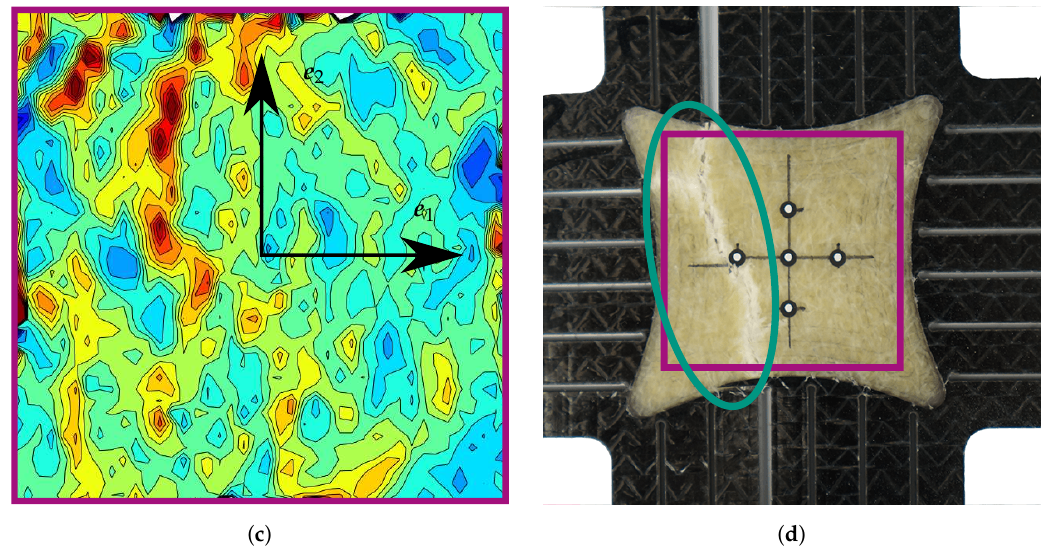
Figure A5. Continuous fiber specimen arms, geometry 2. Last image of strain field before failure and failed specimen. ( a ) strain field ε 11 in A I for load case P Γ = 0 ; ( b ) failed specimen for load case P Γ = 0 ; ( c ) strain field ε 11 in A I for load case P Γ = 1 ; ( d ) failed specimen for load case P Γ = 1